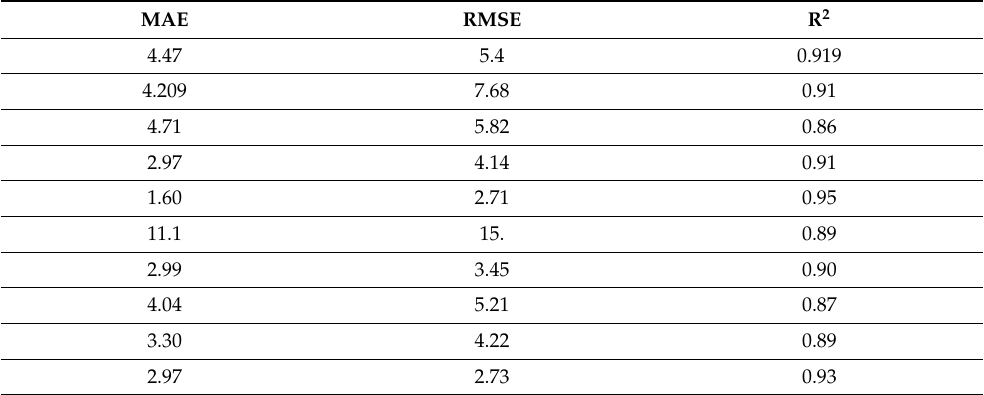
Table 7. Statistics for K-fold Validation.